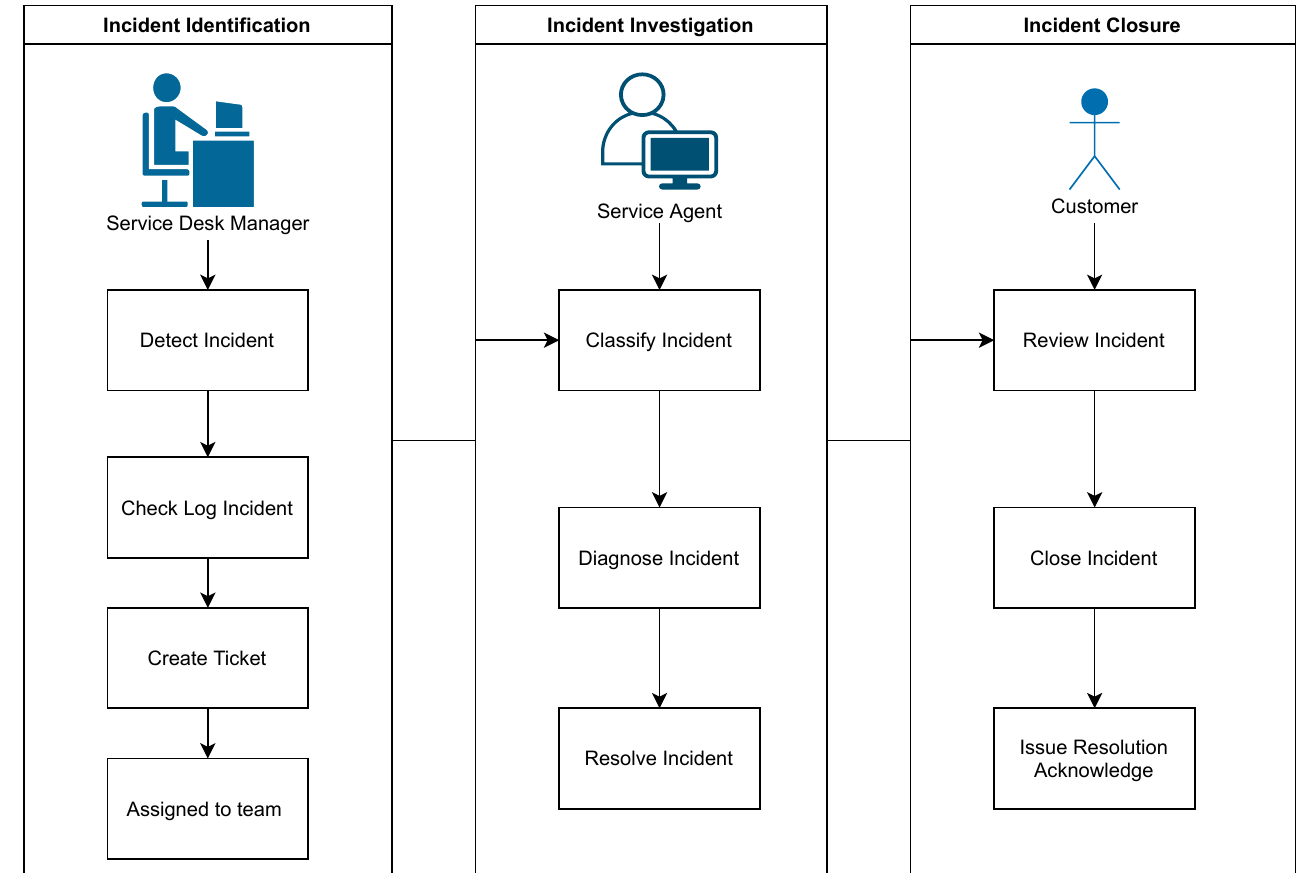
Figure 1. Overview of IT incident management